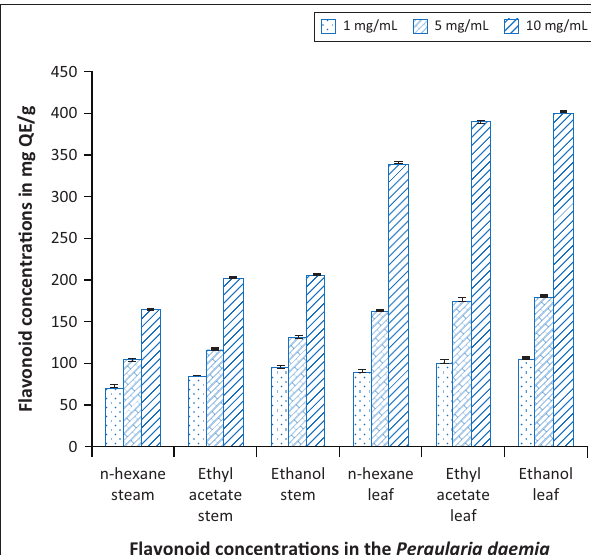
FIGURE 2: Estimated flavonoid concentrations in the stem and leaf of Pergularia daemia at 1 mg/mL, 5 mg/mL and 10 mg/mL of each